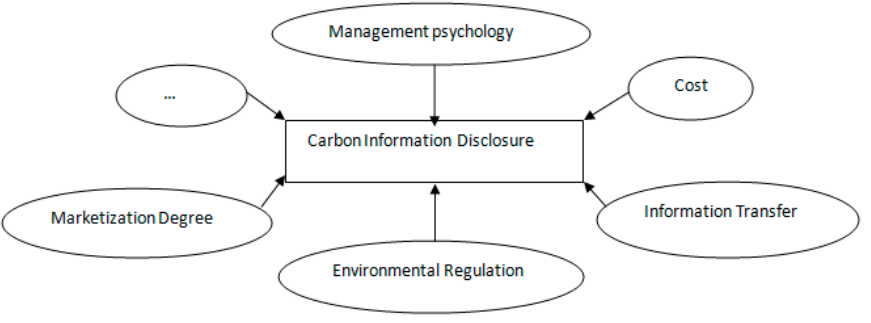
Figure 1. Influencing factors of carbon information disclosure.